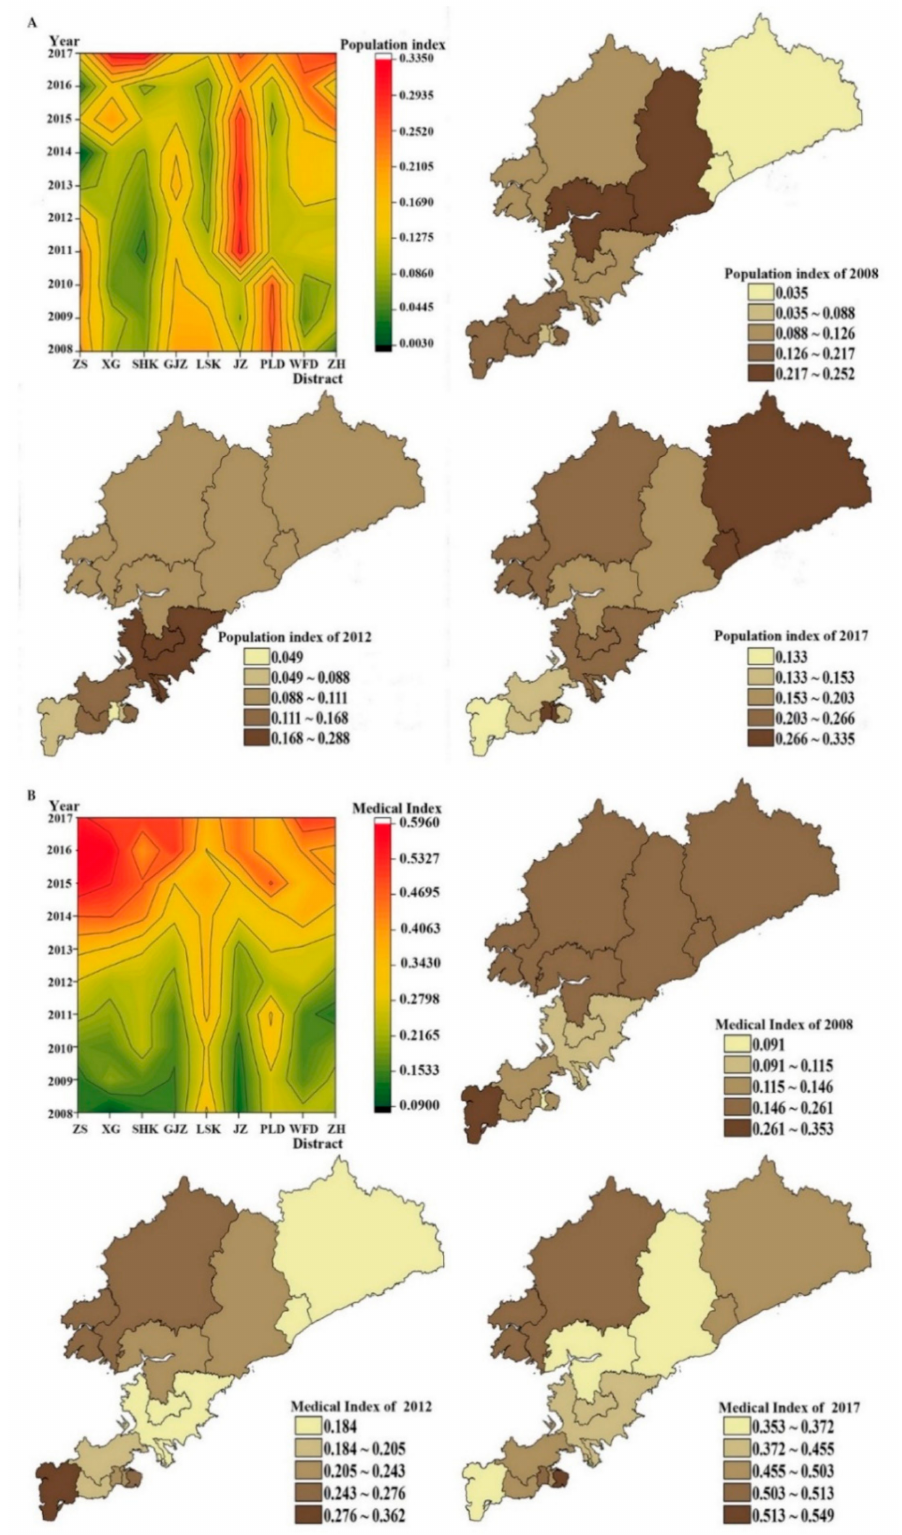
Figure 2. Population index and medical index between urban and rural areas ( A for Population index, B for medical